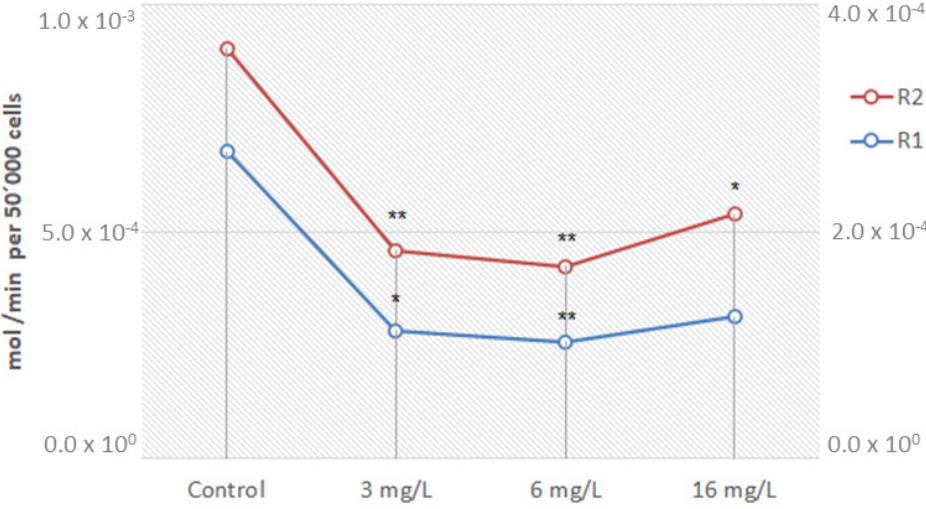
Figure 8. Metabolic effect in B16F1 cells after norcantharidin exposure. Data are presented as resazurin oxidized (mol/min) per 50,000 cells in duplicate (R1 right vertical axis and R2 left vertical axis; ANOVA p (same) 1.67 × 10 − 4 and 5.4 × 10 − 3 , respectively). * p < 0.05; ** p < 0.01 compared to the control group.